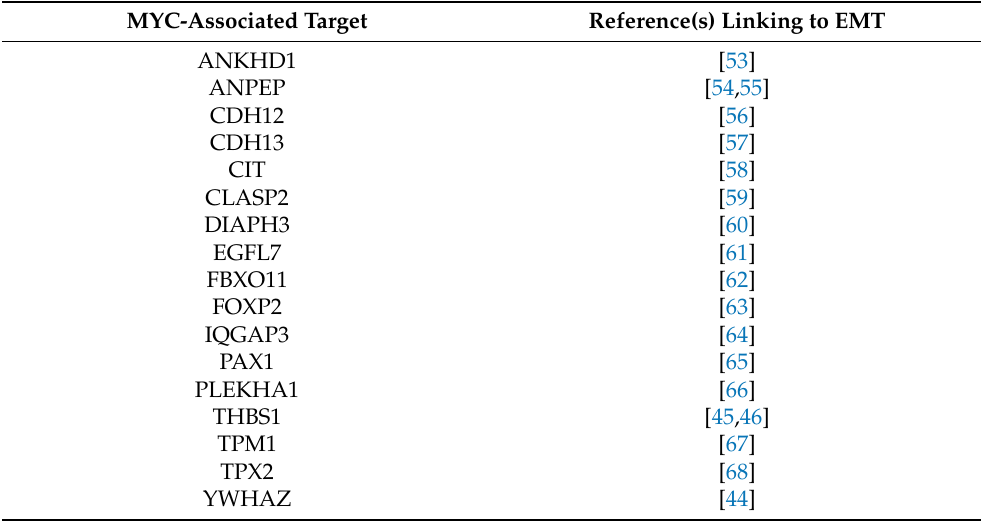
Table A2. Proteins elevated in case plasmas that are associated with MYC and EMT.